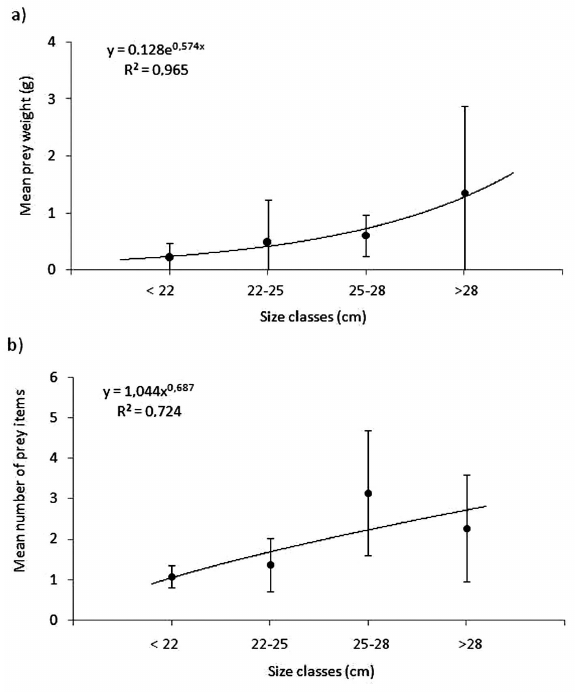
Fig . 9. – Relationship between Labrus mixtus size classes and (A) mean prey weight ± standard deviation; (B) mean number of prey items ± standard